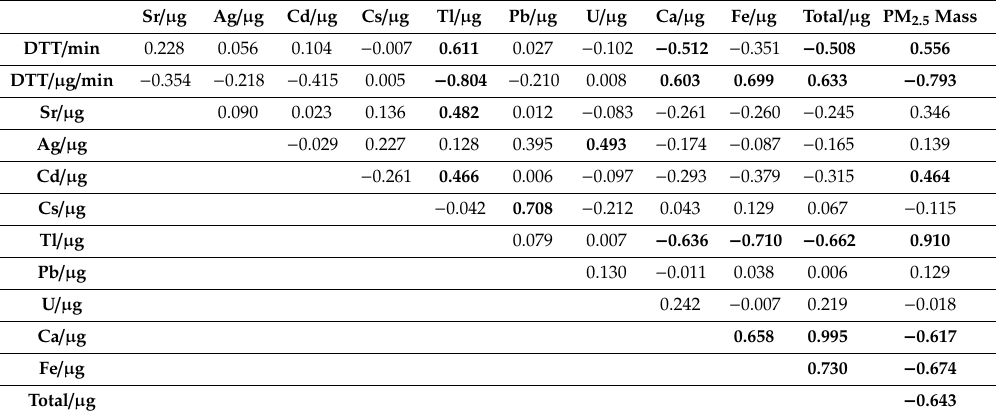
Table 2. Pearson’s Correlations for DTT, elements in ng / µ g PM 2.5 , and PM 2.5 . Sr / µ